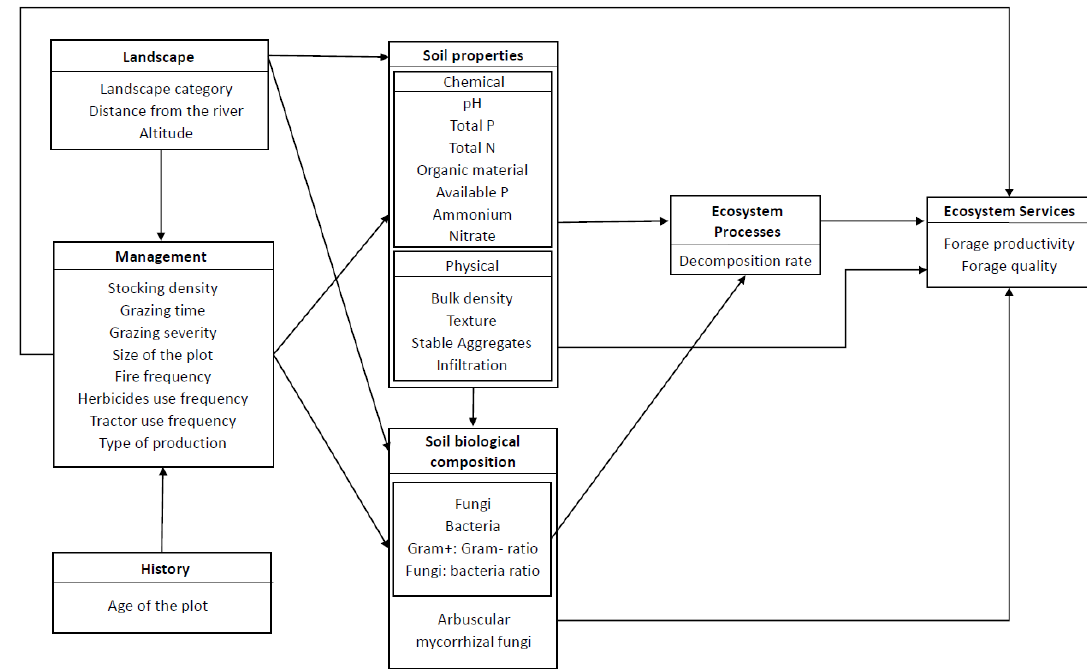
Figure 1. Conceptual model showing possible causal relations among variables considered in this study. Livestock management practices may have an effect on ecosystem services either in a direct or an indirect way. Inside boxes all measured variables are listed. Arrows represent either positive or negative hypothesized relations between boxes.